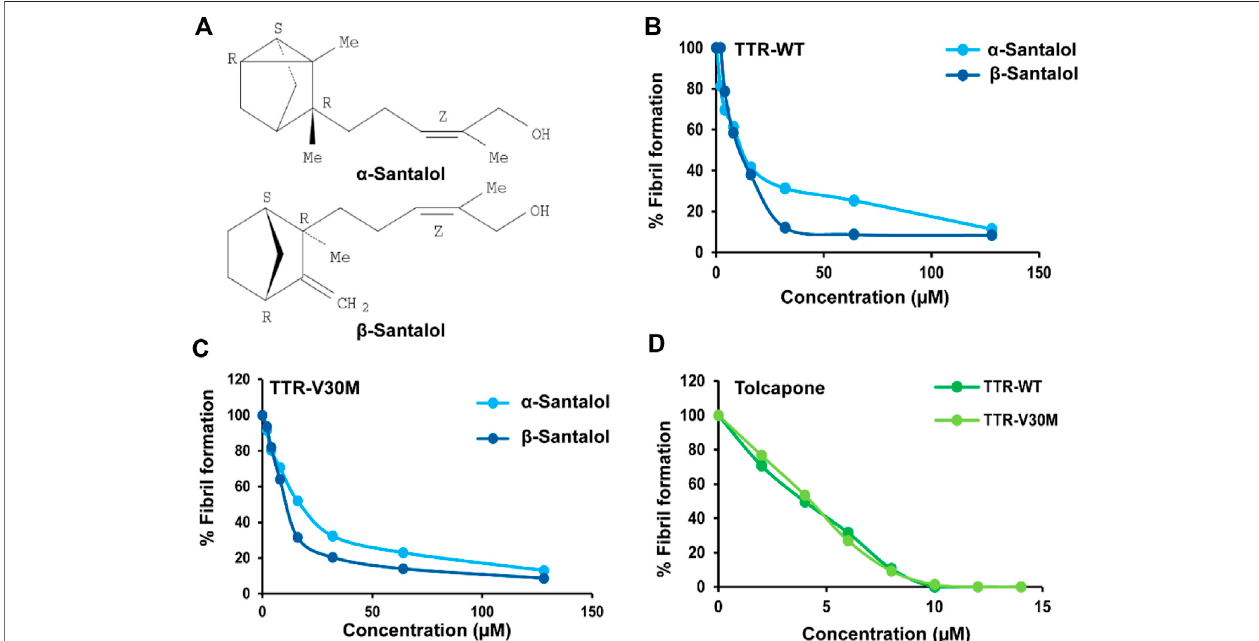
FIGURE 1| Santalol isomers effects over TTR WT and TTR V30M aggregation. (A) Chemical structure oftricyclic α - and β -santalol extracted from Santalum album L., oil. Anti-amyloidogenic effect of (B,C) santalol isomers and (D) tolcapone (positive control) on TTR WT and TTR V30M . TTR solutions were incubated with multiple concentrationsofsantalolisomersortolcapone,andaggregation wasinducedbyacidi fi cation (pH4.2;72 h).Turbiditywasmeasured at340 nm,andthepercentage of TTR aggregation was calculated. Combined data from four independent biological trials were presented, each performed in